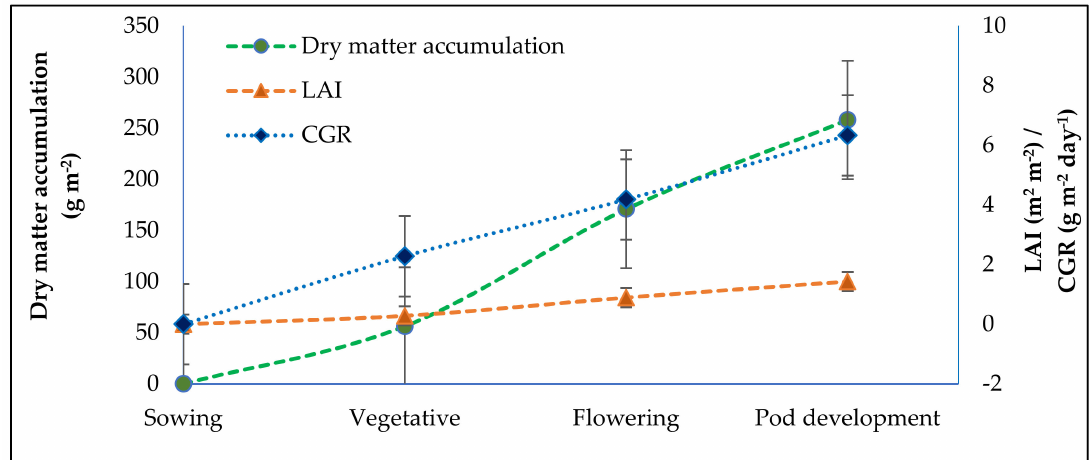
Figure 3. Growth characters at different phenophases of grass pea (pooled means of 2